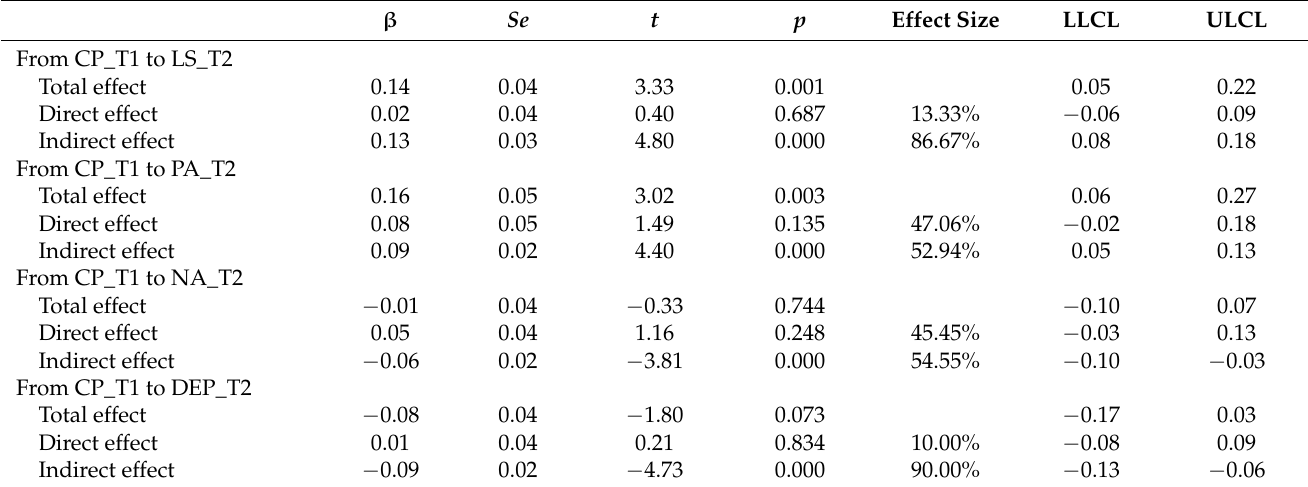
Table 3. Total effect, direct effect, and indirect effect.